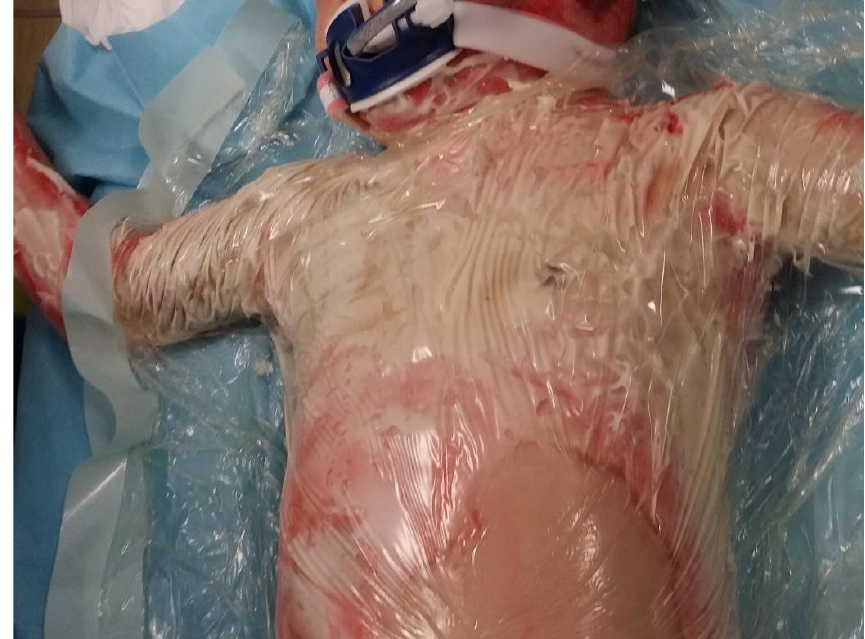
Figure 2. Nexobrid ® application.